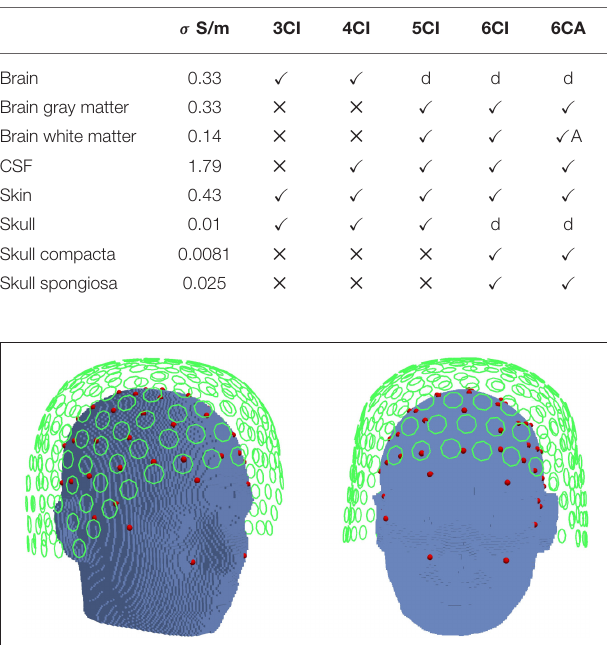
TABLE 1 | Overview of the compartment conductivities, the conductive features of the different head models ( X is regarded, 5 is disregarded, and d is regarded but further divided, A is anisotropic).